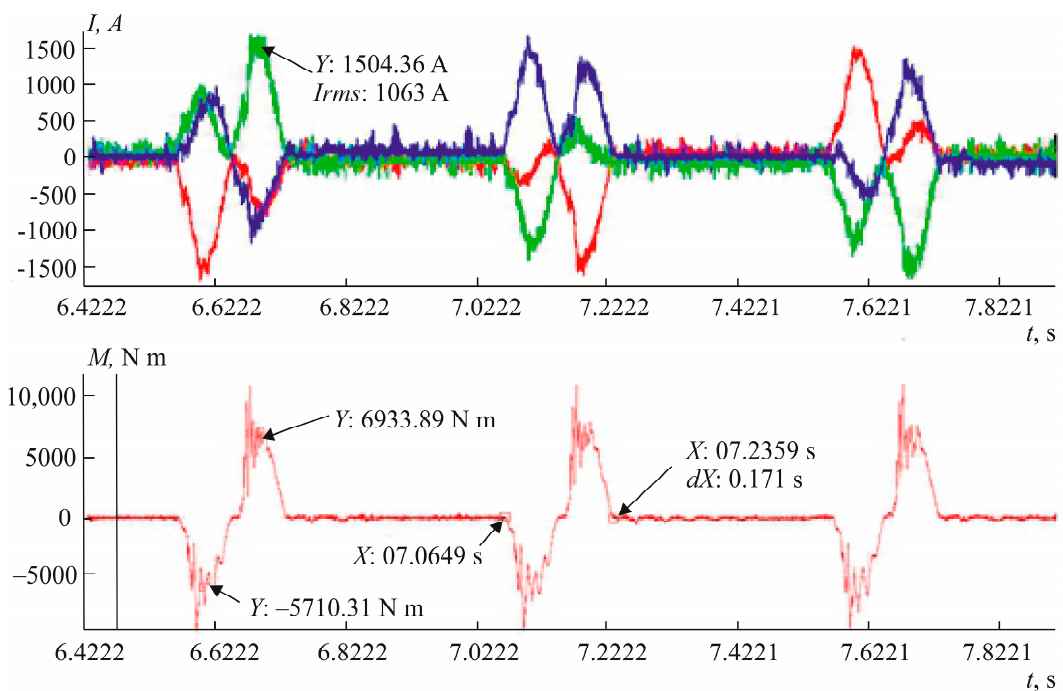
Figure 10. Oscillograms of transient processes of the electric drive of rotation of the HPT-250